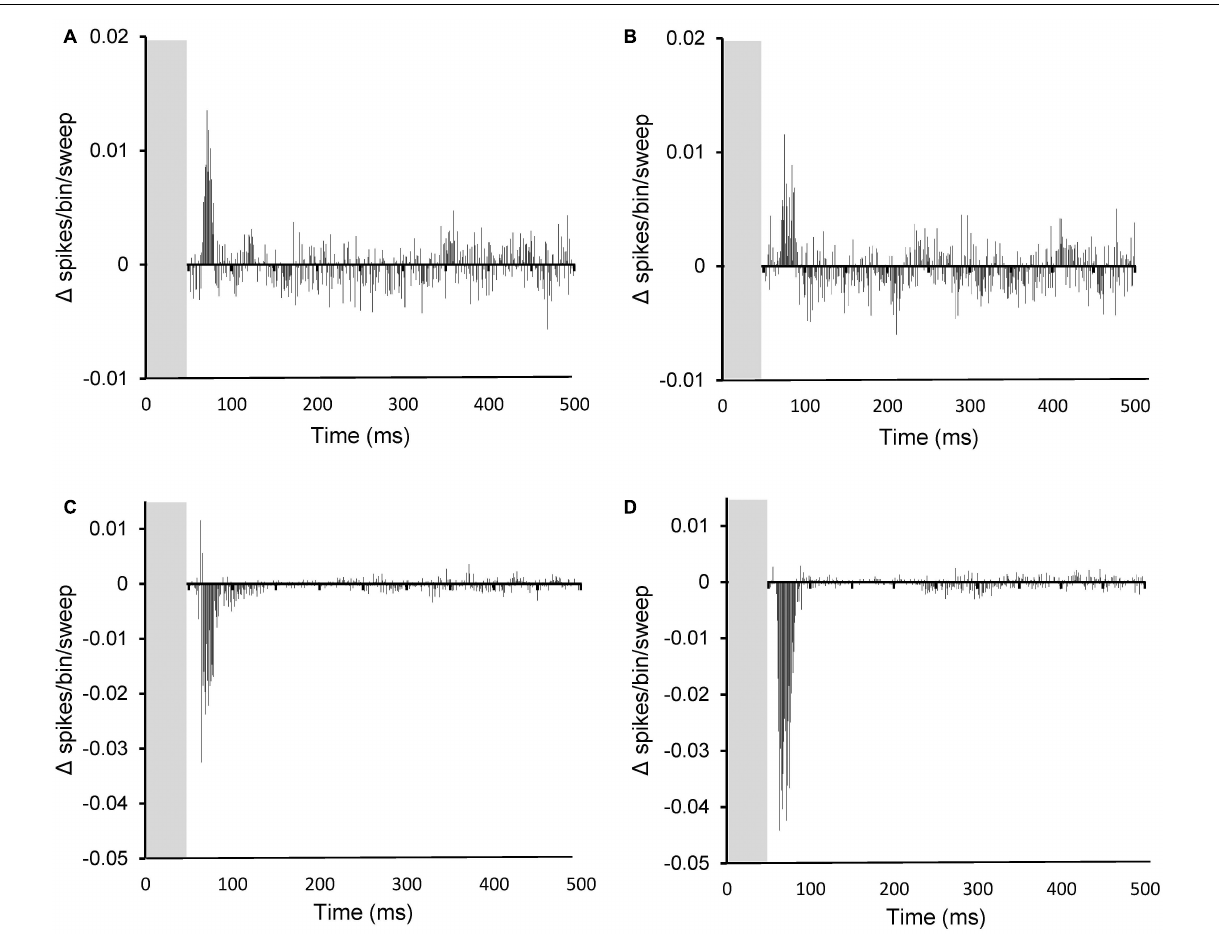
FIGURE 8 | Peristimulus time histograms (PSTHs) showing the summed difference between PSTHs (per bin) with and without PFC stimulation on spontaneous activity (A,B) and on sound evoked activity (C,D) . (A,C) data from sham animals and (B,D) , data from AT animals. Note the increased inhibition after AT on sound evoked responses (compare panel C and D ). (A) Based on 11 PSTHs, (B) on 26 PSTHs, (C) on 58 PSTHs, and (D) on 57